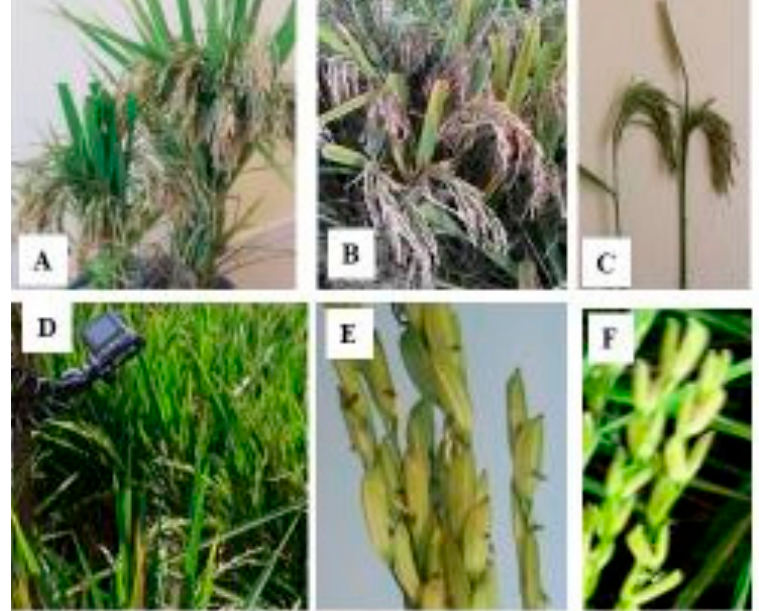
Figure 2. Improved floral and agronomic characteristics of newly-bred CMS lines. ( A ) Good agronomic traits of CMS line; ( B ) high outcrossing rate of improved CMS line as a result of desired floral characteristics; ( C ) good panicle exertion for CMS (left side) and maintainer lines (right side); ( D ) the use of a digital camera to record spikelet characteristics; ( E ) good stigma exertion for newly-bred CMS lines; ( F ) large glume opening of newly-bred CMS line.